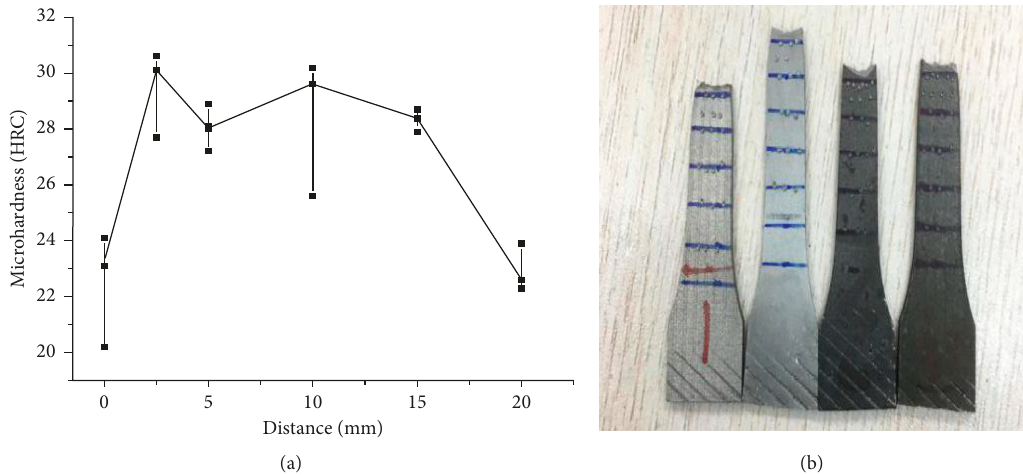
Figure 11: Microhardness. (a) Hardness curve. (b) Hardness physical image.